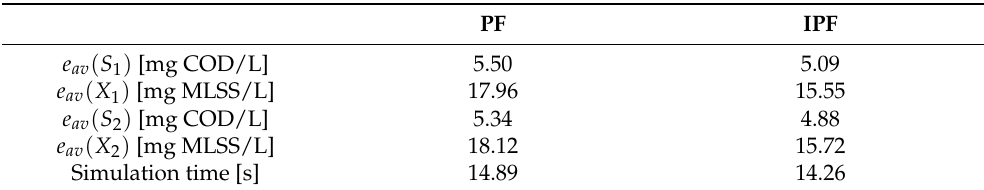
Table 4. Comparison of the PF and IPF with regard to the average error ( e av ) and simulation time. N r = 10, N S = 30, T = 4000.